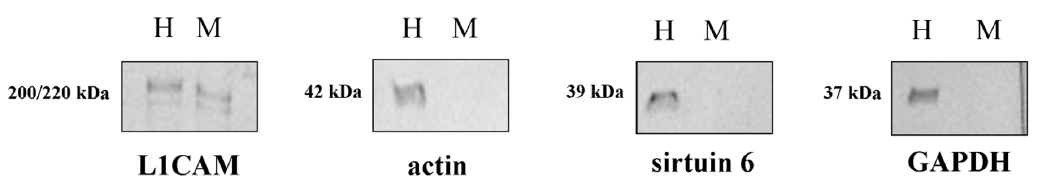
Figure 4. Assessment of the membrane fraction purity. On-blot immunodetection of proteins representative of each subcellular fraction was performed for the whole-cell extracts and the membrane fractions obtained from Mel202 cells. An antibody against L1CAM was used as a control for the membrane fraction, an antibody against actin for the cytoskeletal fraction, antibody against sirtuin-6 for the nuclear fraction, and an antibody against glyceraldehyde 3-phosphate dehydrogenase ( GAPDH) for the cytosolic fraction. The reaction with Phaseolus vulgaris leukoagglutinin (PHA-L) confirmed the presence of β 1,6-